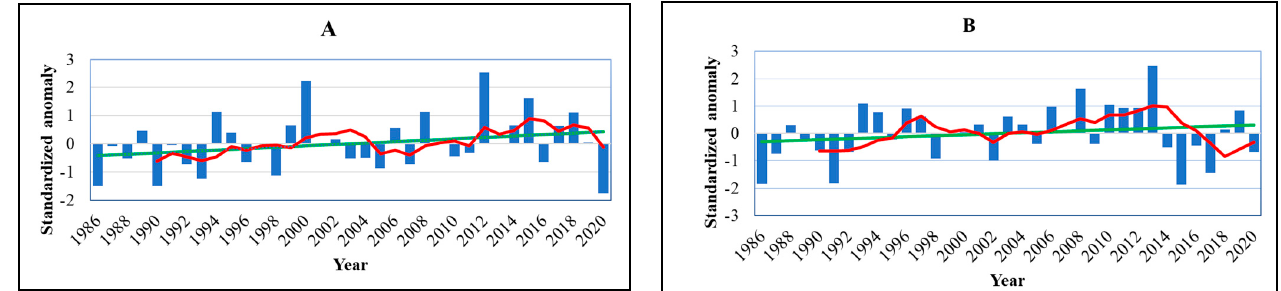
Figure 6. Time series diagram of the mean country-wide extreme rainfall indices in the period between 1986 and 2020: ( A ) CDD, ( B ) CWD. Note: The straight green line is the linear trend for the variables while the red curved line is the five-year moving average.